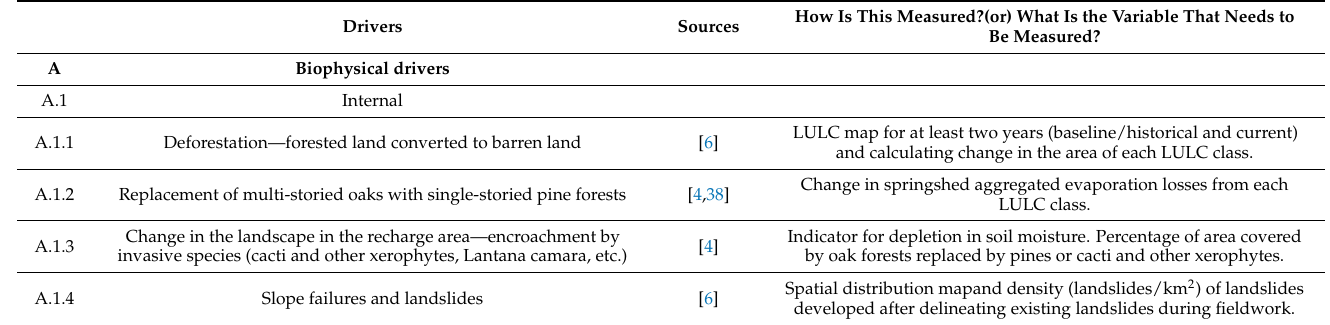
Table 4. Measurable properties for characterization of